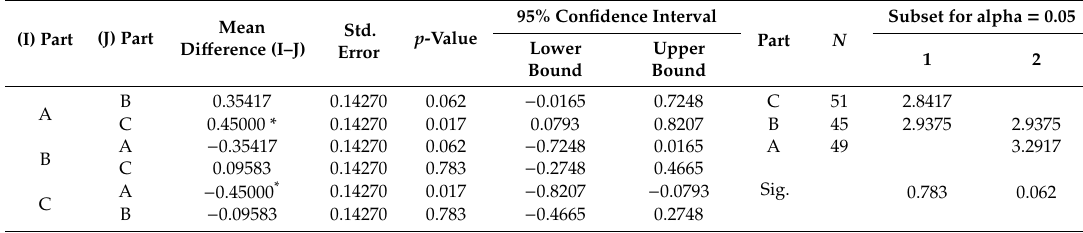
Table 10. Tukey PTC analyses in the three investigated intersections (A, B and